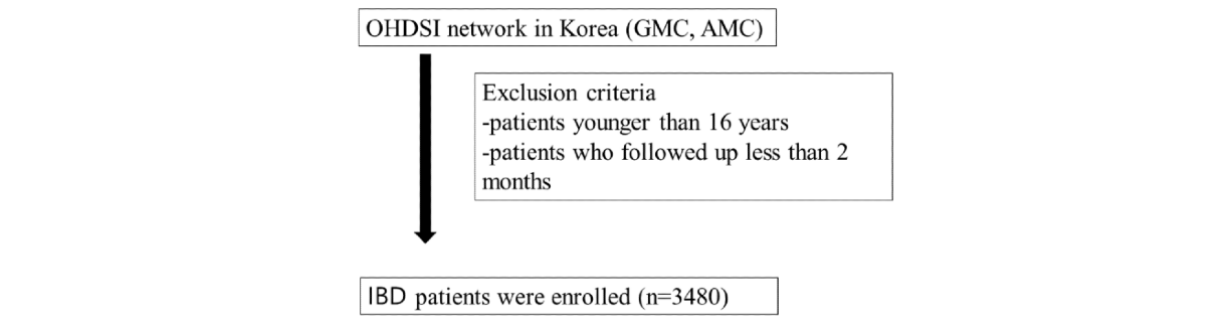
Figure 1. Study flow. OHDSI: Observational Health Data Sciences and Informatics Network; GMC: Gil Medical Center; AMC: Ajou Medical Center; IBD: inflammatory bowel